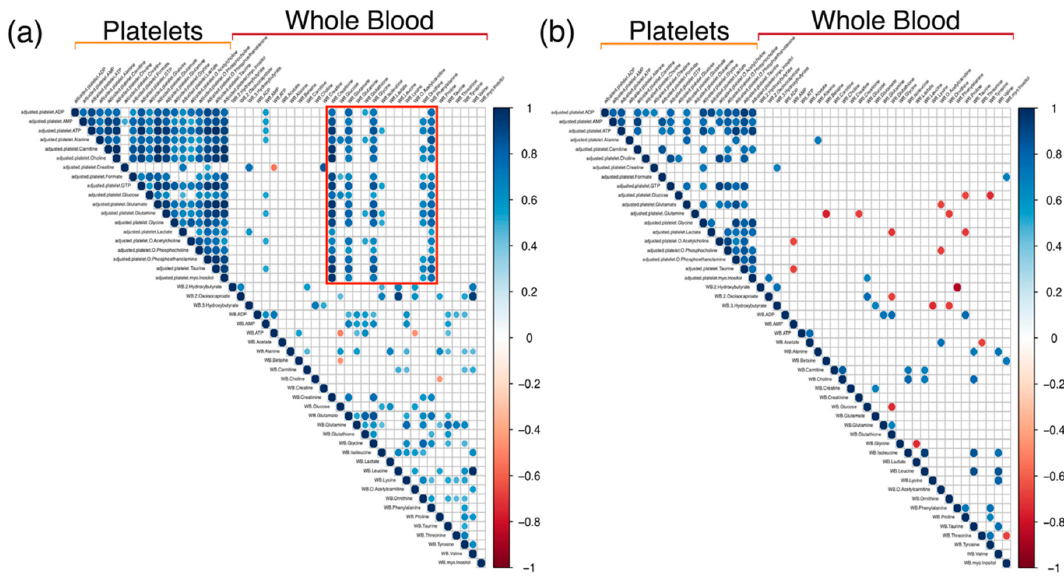
Figure 1. Significant associations were found between whole blood and platelet metabolites. In sepsis patients, ( a ) several whole blood metabolites (creatinine, glutamate, glycine, ornithine, phenylalanine) were significantly and positively correlated with at least 12 / 19 (63%) of the detected platelet metabolites; these are contained within the red box. These significant correlations were not present in the ( b ) control subjects. p -values of ≤ 0.05 were considered significant. Matrices were generated in RStudio using Pearson’s correlation coefficient (r) with a scale of − 1 to 1.